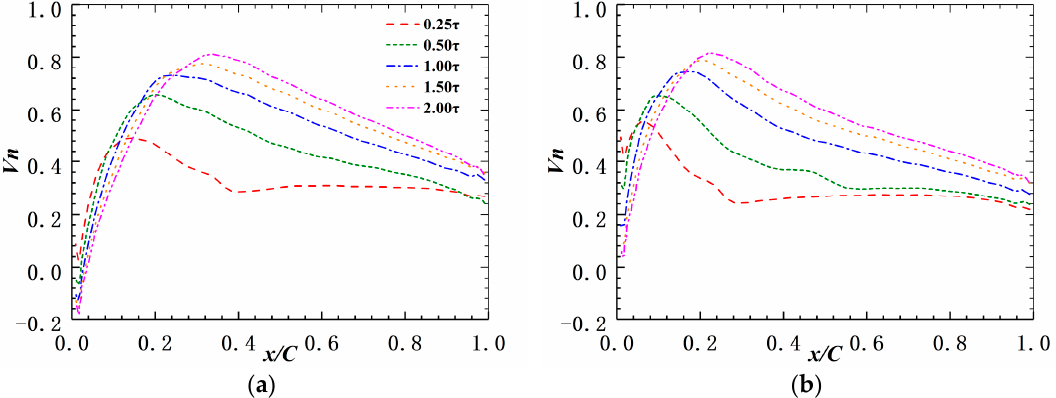
Figure 12. Distribution of the normalized normal component of leakage flow velocity at the suction side of the stator hub gap along the blade chord. ( a ) In the DE condition; ( b ) in the NS condition. It can be seen that in the DE condition, at most places the streamwise velocity of 0.00